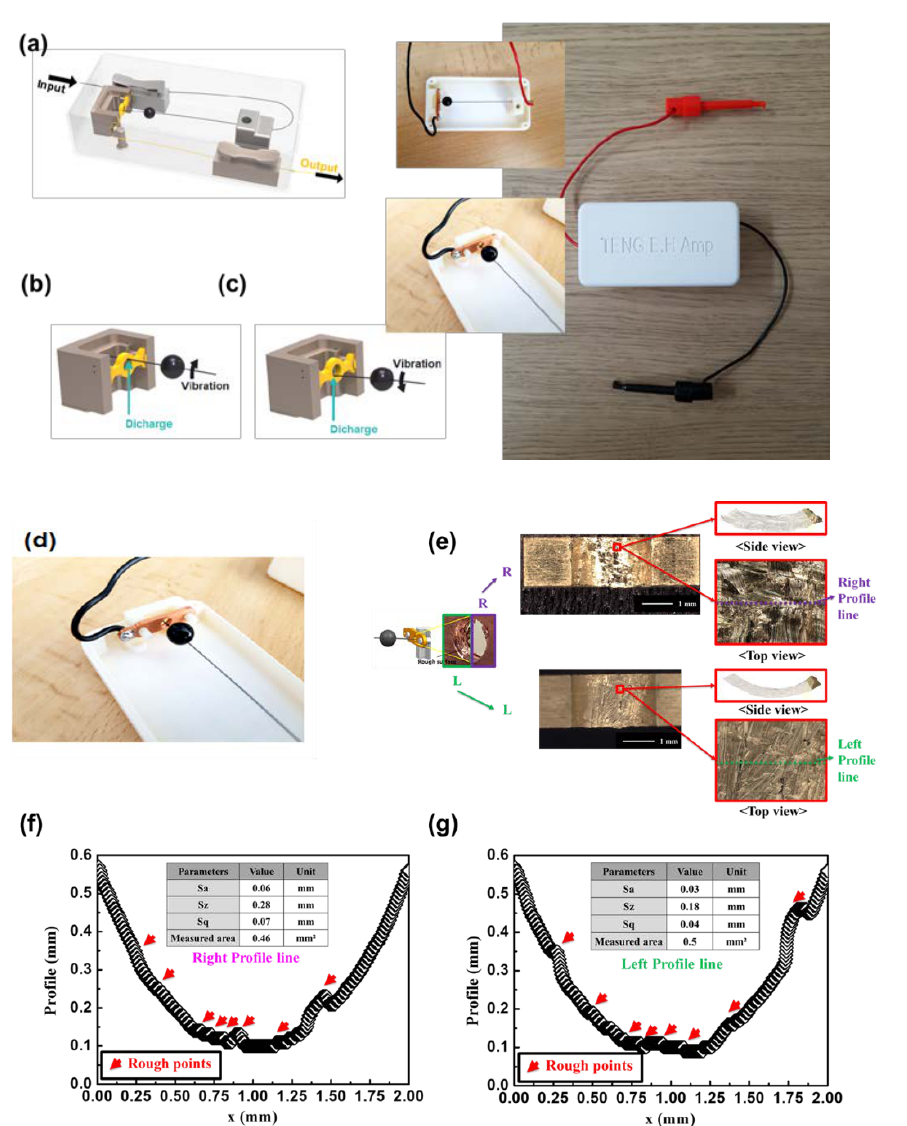
Figure 2. TENG output amplifier (TENG Amp.). ( a ) Exterior and interior design of TENG Amp and real TENG Amp. ( b ) Principle of TENG Amp. during clockwise rotation of vibration. ( c ) Principle of TENG Amp. during counter clockwise rotation of vibration. ( d ) Real mass and bar. ( e ) Rough contact surface in a hole shape, which functions similar to a lightning rod. ( f ) Roughness profiles of contact surface of right part. ( g ) Roughness profiles of contact surface of left part.